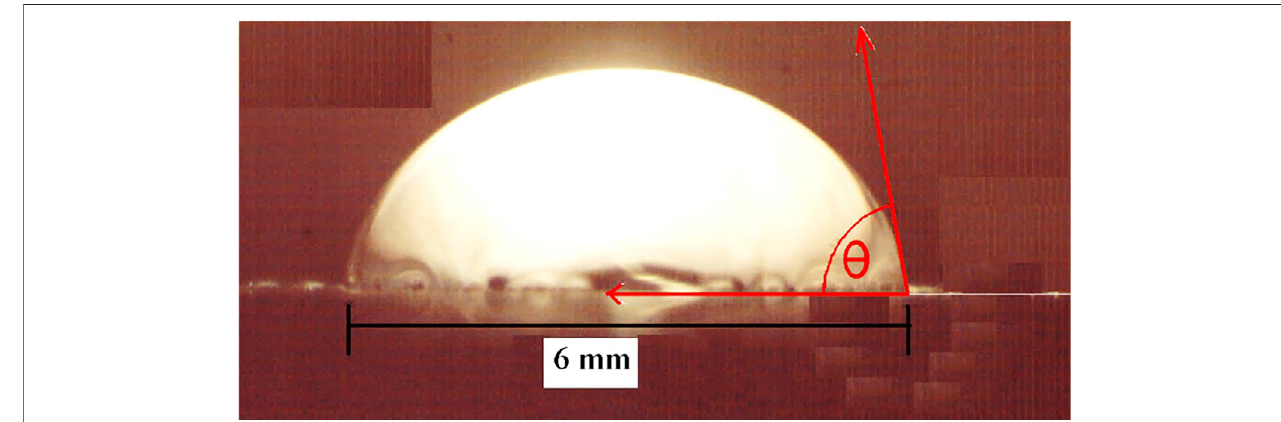
FIGURE 4 | Water droplet contact angle, θ on a ground ski base. Viewed from an edge across the ski base.